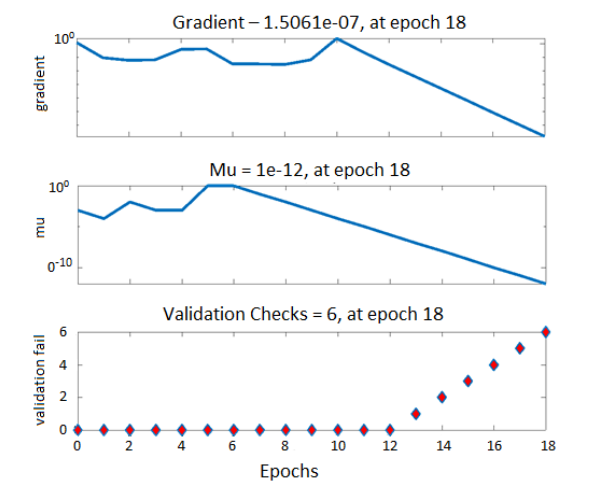
Figure 13. NET1_HF neural network